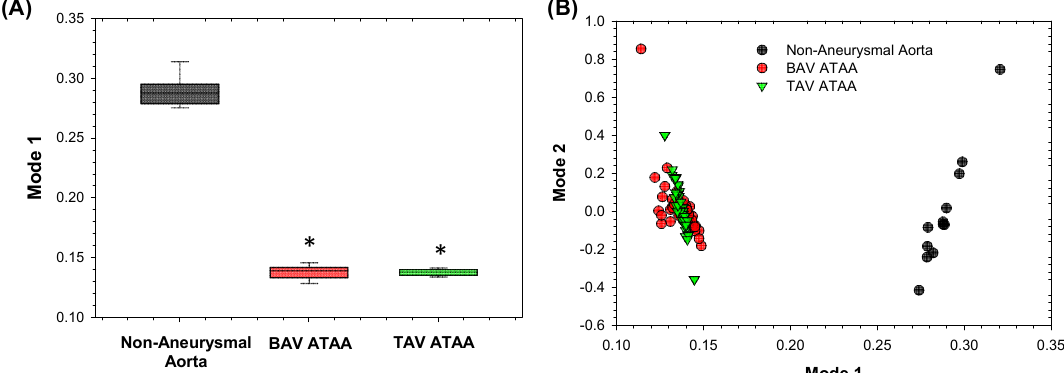
Figure 8. ( A ) box plots of mean values of Mode 1 for all groups; * denotes statistically significant difference with non ‐ aneurysmal aorta; ( B ) revealed grouping for all groups.